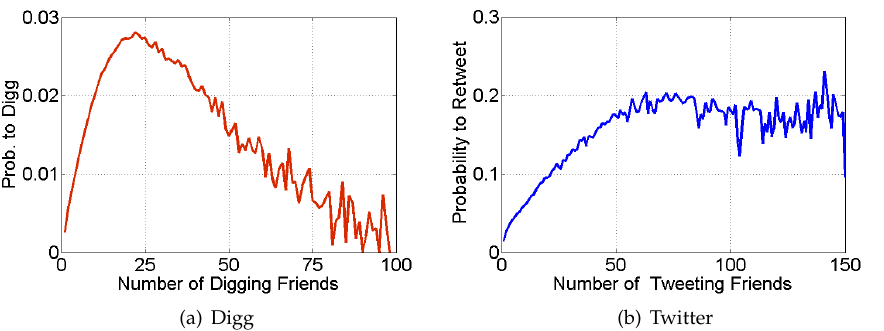
Figure 3. The exposure response function for social media users. The figures report the probability (averaged over all users) to respond to information, i.e. , ( a ) to digg a news story or ( b ) retweet a URL, as a function of number of friends who previously did